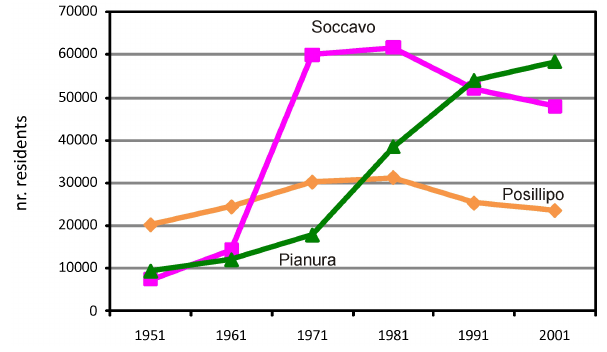
Fig. 3. 1951–2001 trend of residents in the boroughs of Posillipo, Soccavo and Pianura (data from MGCN,